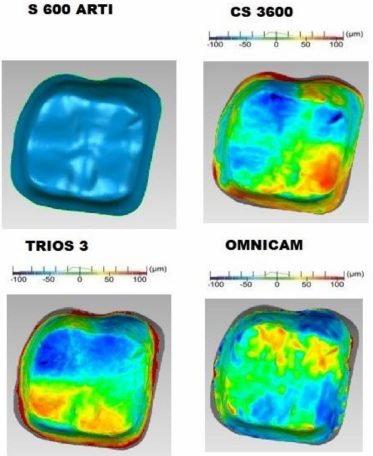
Figure 9. Comparison of the complete preparation in OVA rendering S600ARTI and 3D comparison analysis for IOS with saliva in relation to the sample 1. Nominal histogram settings ± 25 microns and critical ± 100 microns.